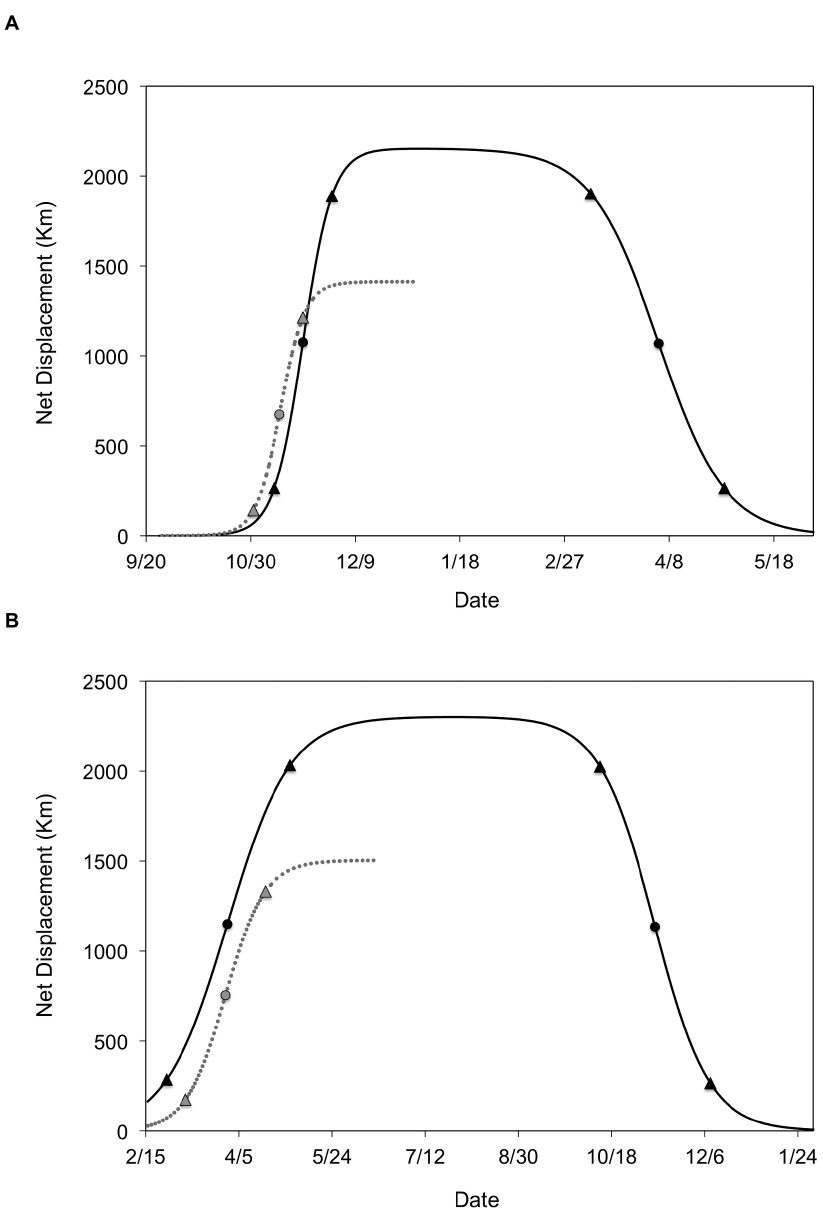
Figure 5. Nonlinear mixed-effects migration models for ducks marked in Saskatchewan, Canada (top pane) and Arkansas, USA (lower pane). Predicted net displacement is displayed on the y-axis and time is on the x-axis. Black lines represent predicted ND values over time for the double-sigmoid model and gray lines represent predicted values for the single-sigmoid model. The population level midpoints (circles) and initiation and termination of migration are also displayed (triangles) for single- and double-sigmoid models.